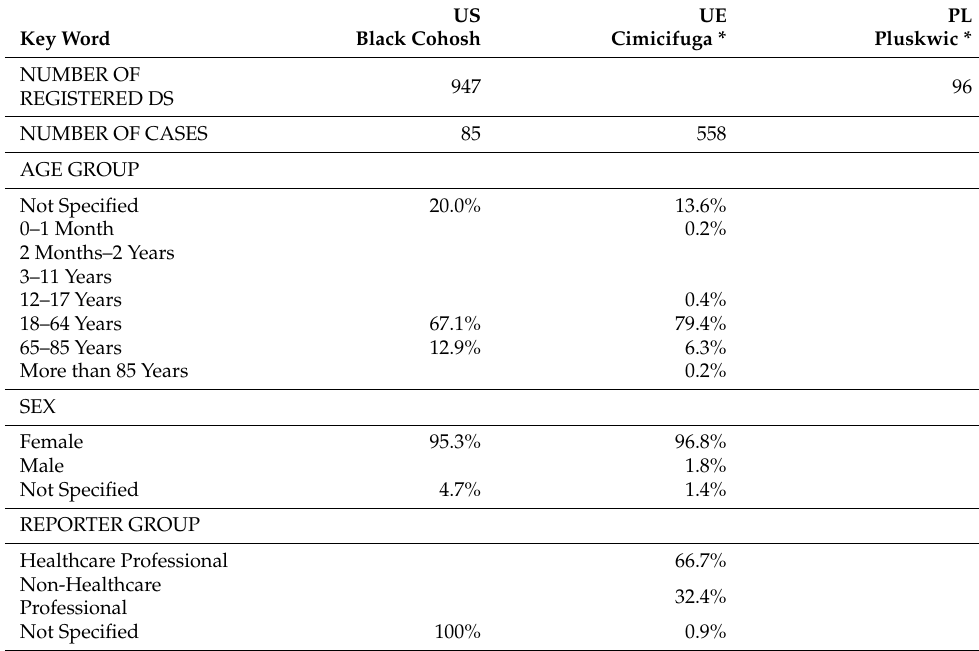
Table 8. Comparison of data on Cimicifuga from different